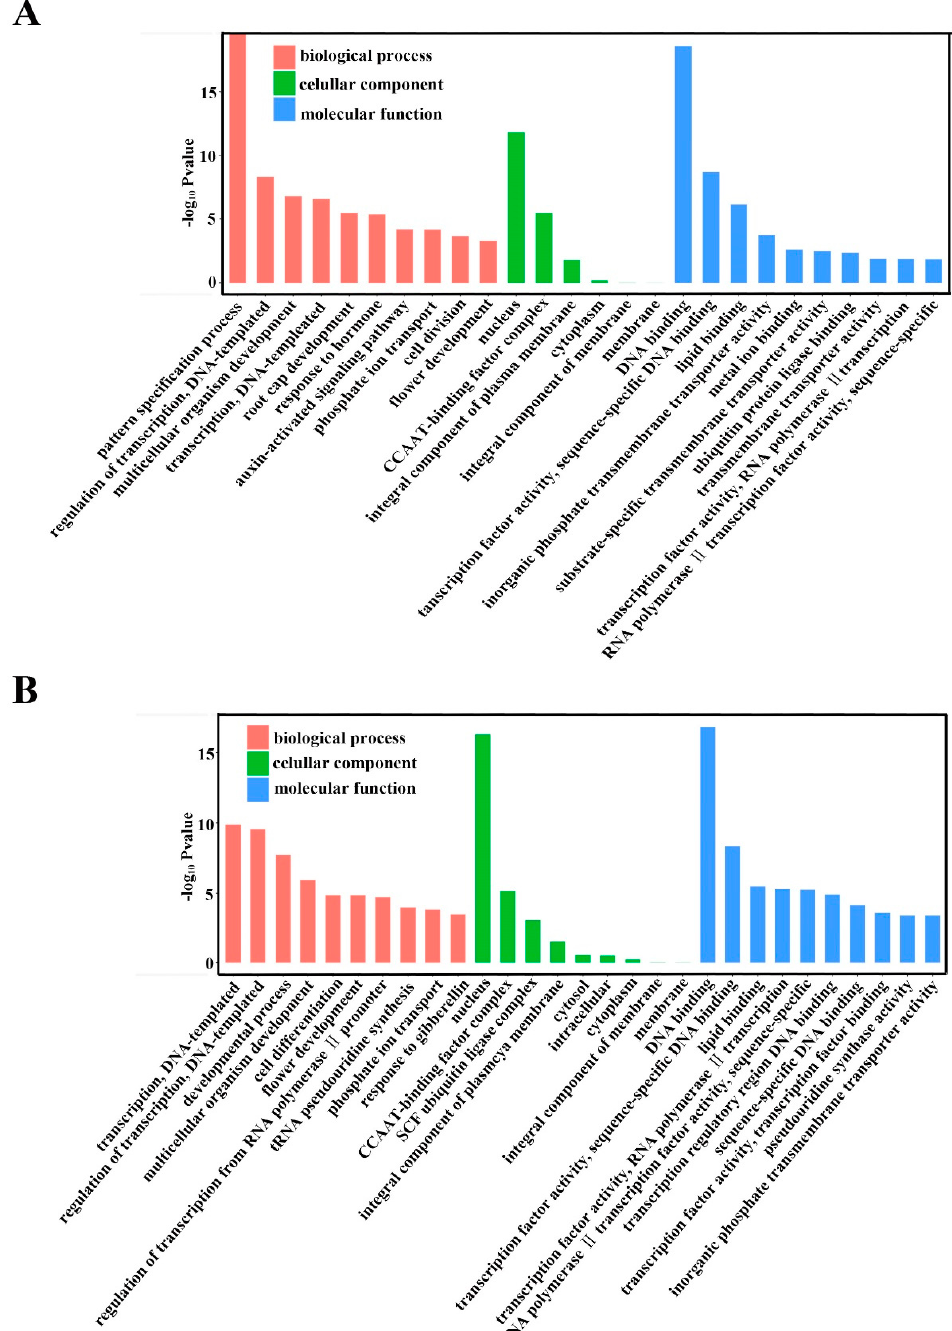
Figure 9. Gene ontology categories of the predicted target genes of the di ff erentially expressed miRNAs in grape. ( A ) Gene ontology categories of the predicted target genes of di ff erentially expressed miRNAs between RR-1 and RR-2. ( B ) Gene ontology categories of the predicted target genes of di ff erentially expressed miRNAs between CK-1 and CK-2.